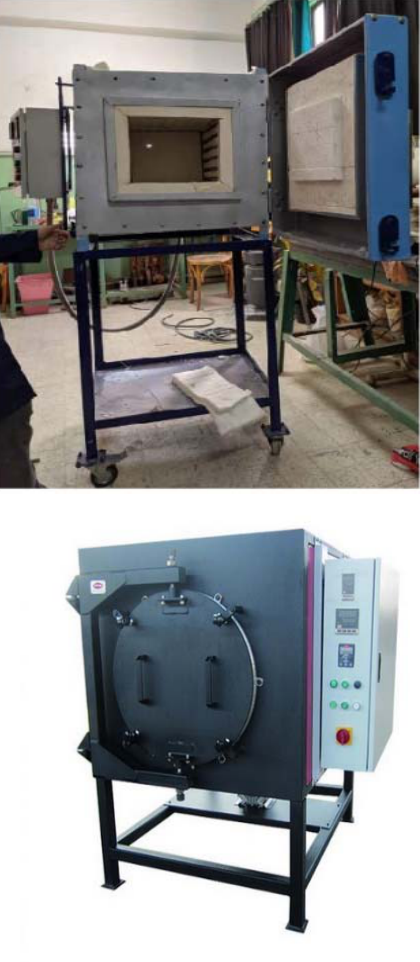
Fig. 1a. Two Electric Furnaces for heat treatment.